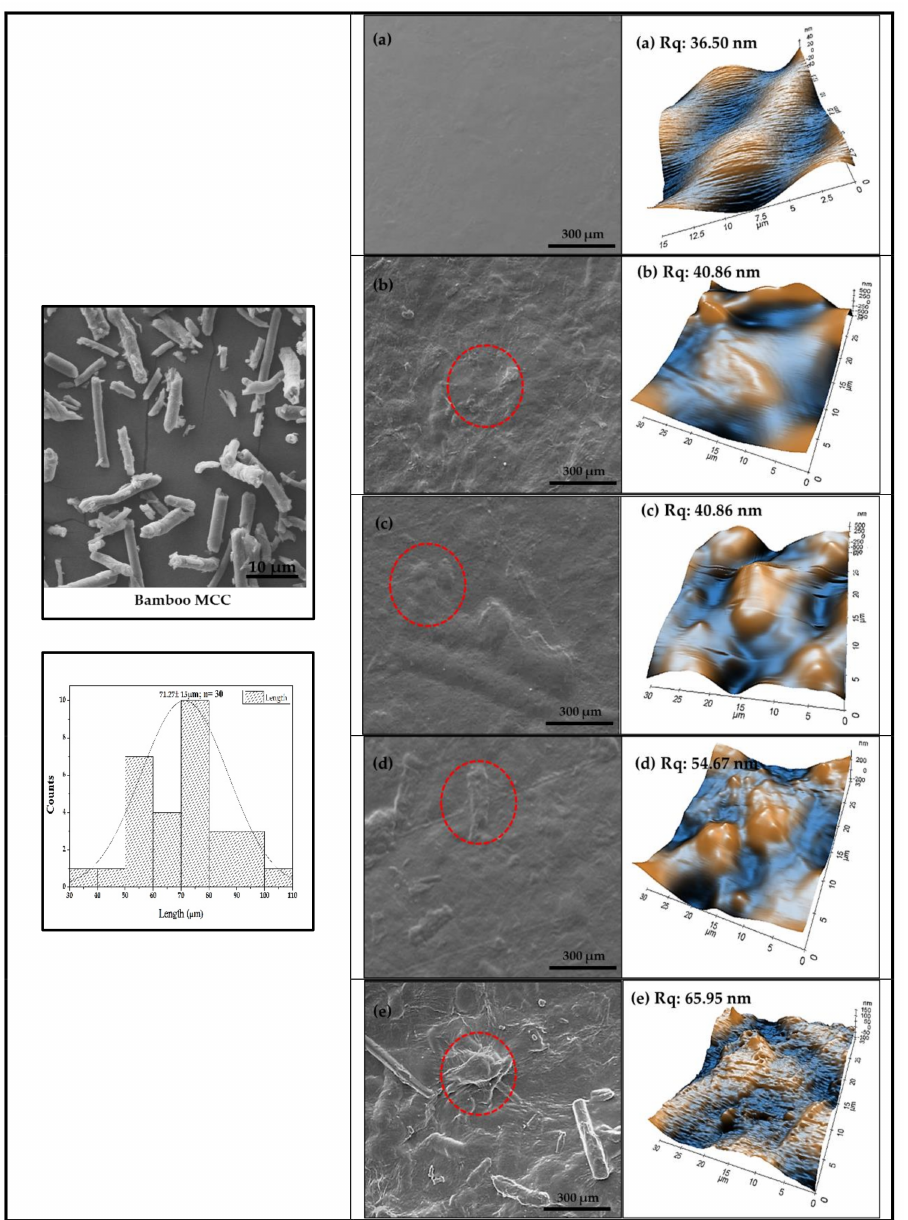
Figure 2. The surface morphologies of macroalgae (SW) / polysaccharide microfibre (GL-MCC) biopolymer films by scanning electron microscope (SEM) and atomic force microscope (AFM) for ( a ) Plain-SW, ( b ) SW / 2% GL-MCC, ( c ) SW / 4% GL-MCC, ( d ) SW / 6% GL-MCC, and ( e ) SW / 8%